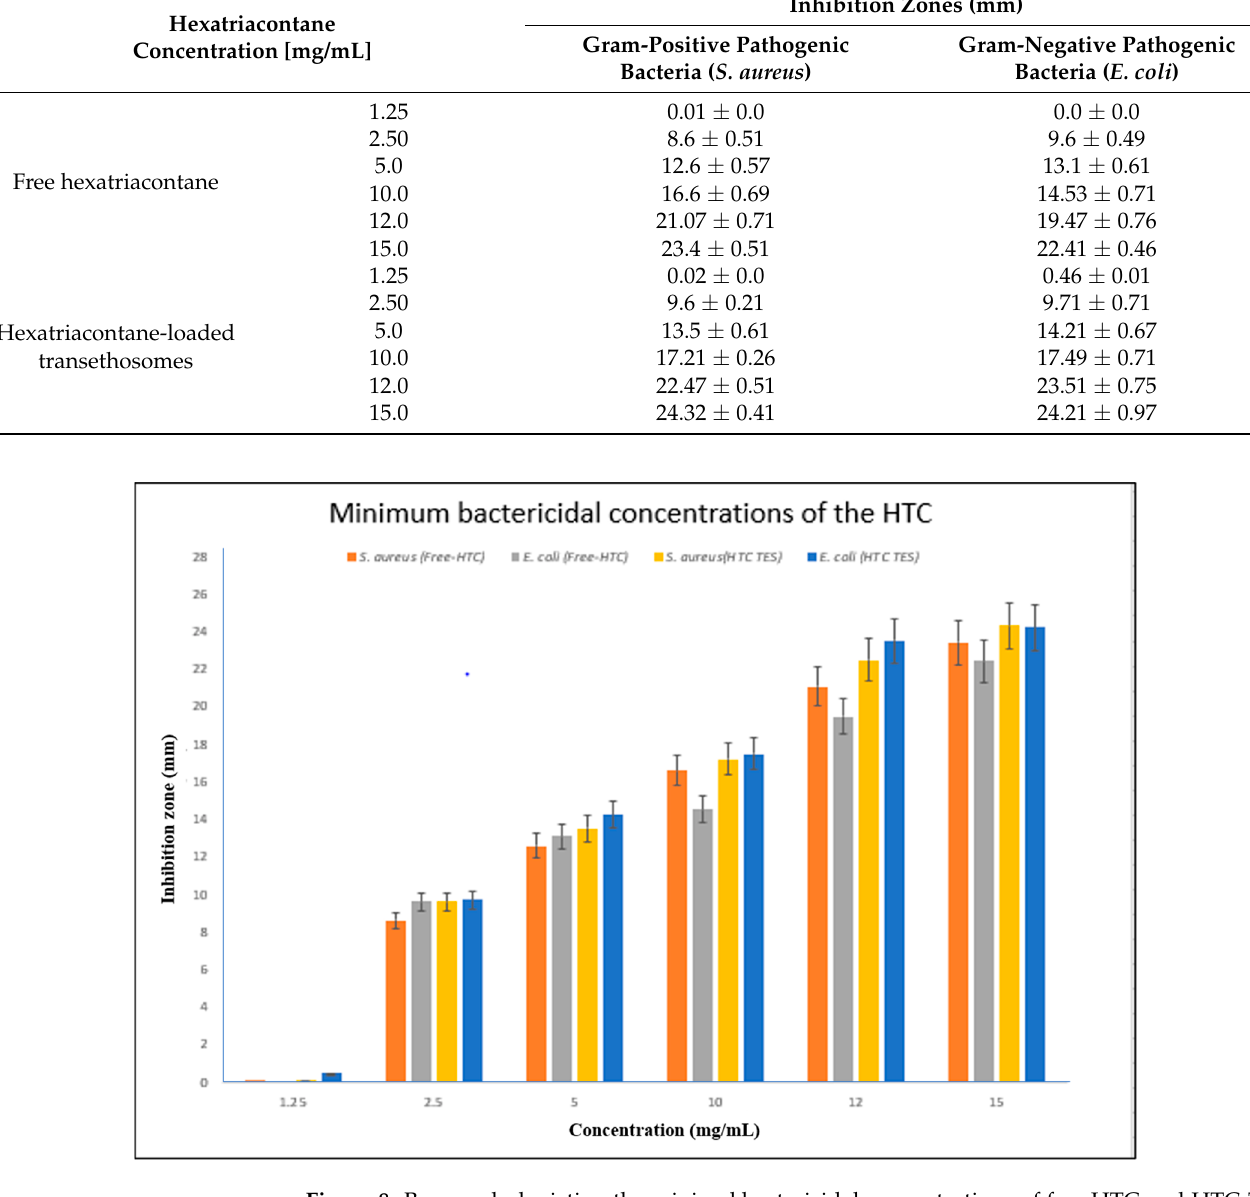
Figure 8. Bar graph depicting the minimal bactericidal concentrations of free HTC and HTC-TES against S. aureus and E. coli ( p -value less than